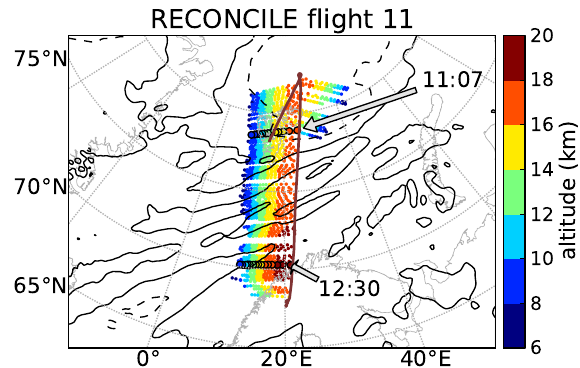
Fig. 4. Plot of tangent point locations of CRISTA-NF measurements taken during RECONCILE flight 11, the second flight of 2 March 2011. The flight path is drawn in dark red. The Locations of every fourth tangent point are drawn as circles with colour code according to tangent point altitude. Thick black contour lines indicate a potential vorticity of 20 PVU at 17 km at 12:00 UTC (indicating the position and orientation of filaments across the flight path and dashed black contour lines show 26 PVU at the same altitude and time (roughly indicating the location of the polar vortex core).